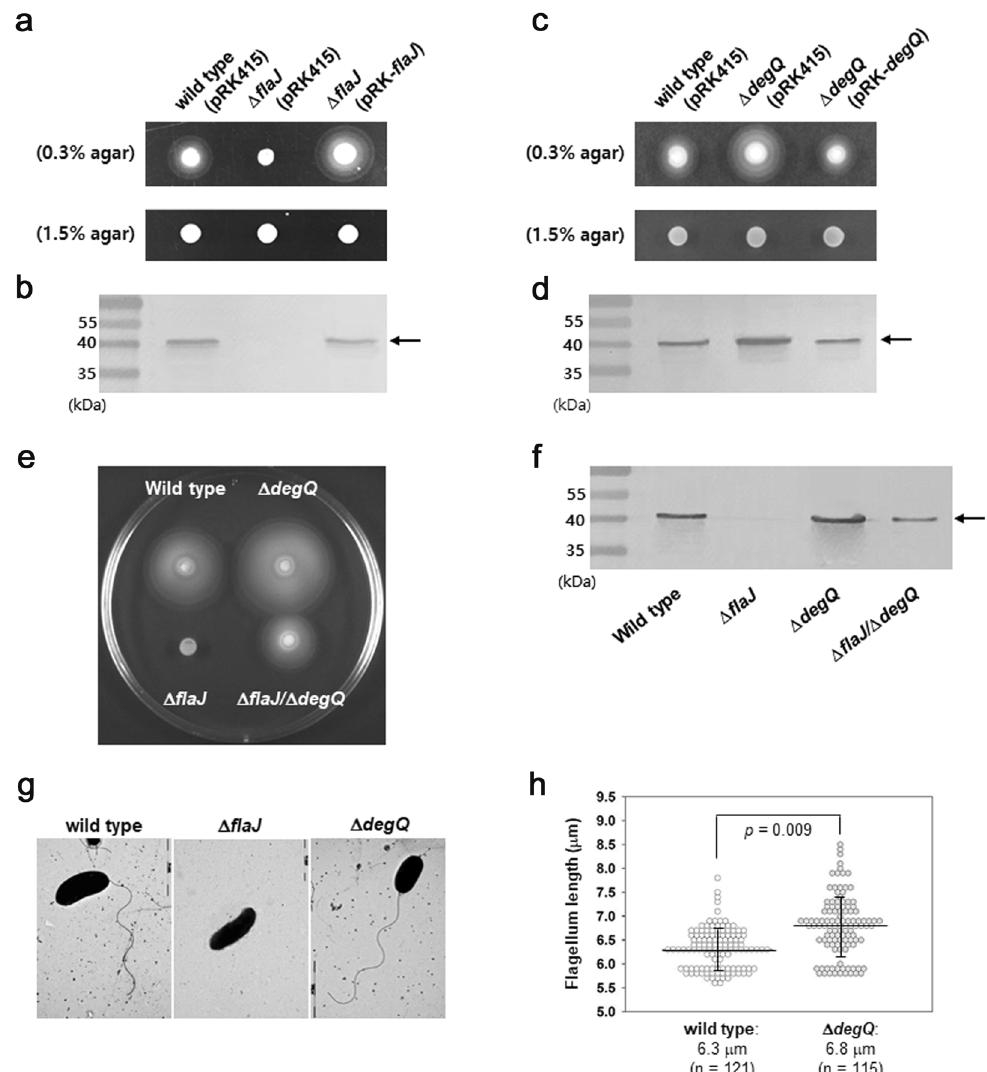
Fig. 1 Effects of the mutations in fl aJ or degQ genes on fl agellins, fl agella, and motility. a Effect of FlaJ on swimming motility on the soft- agar plate. Five microliters of the freshly grown cultures (at an OD of 1.0) of V. vulni fi cus strains of wild type and Δ fl aJ carrying a broad-host- range vector (pRK415) or a pRK415 harboring the intact fl aJ gene (pRK- fl aJ ) were spot-inoculated on a soft-agar plate made of LBS containing 0.3% agar, tetracycline (3 μ g/ml), and IPTG (1.0 mM), and incubated at 30 °C for 6 h. As a control for the inoculum size of each strain, the same volumes of the bacterial suspensions were spotted on the LBS-1.5% agar plate supplemented with tetracycline (3 μ g/ml) and IPTG (1.0 mM). b Effect of fl aJ deletion on the cellular levels of fl agellins. Cell lysates were prepared from the wild type carrying pRK415, Δ fl aJ carrying a pRK415, and Δ fl aJ carrying a pRK415- fl aJ . Ten micrograms of the crude cell extracts were subjected to SDS-PAGE and subsequently western blot analysis using the polyclonal antibodies reacting with the fl agellins produced by V. vulni fi cus , as previously described 12 . An arrow indicated the V. vulni fi cus fl agellin subunits. c Effect of DegQ on swimming motility on the soft-agar plate. V. vulni fi cus strains of wild type carrying pRK415 and Δ degQ carrying pRK415 or pRK- degQ were spot-inoculated on the LBS plates containing agar at a concentration of 0.3 or 1.5%, as described in ( a ). d Effect of degQ deletion on the cellular levels of fl agellins. Ten micrograms of cell extracts of wild type carrying pRK415, Δ degQ carrying pRK415, and Δ degQ carrying pRK415- degQ were subjected to SDS-PAGE and western blot analysis, as described in ( b ). e , f Effects of fl aJ / degQ -double mutations on motility and fl agellin levels. V. vulni fi cus strains of wild type, Δ fl aJ , Δ degQ , and Δ fl aJ / Δ degQ were spot-inoculated on a soft-agar plate and incubated at 30 °C for 8.5 h ( e ), as described in ( a ). Ten micrograms of cell extracts of the four strains were subjected to SDS-PAGE and western blot analysis ( f ), as described in ( b ). g , h Effects of FlaJ and DegQ on fl agellation. Individual cells of V. vulni fi cus strains of wild type, Δ fl aJ , and Δ degQ were observed under TEM to examine the polar fl agellum ( g ), as described in “ Methods ” . Lengths of fl agella on the TEM images were measured from 121 cells of wild type and 115 cells of Δ degQ ( h ). The distribution of fl agellar lengths was plotted with the medians (marked with a horizontal line) and their standard deviations (marked with a vertical line) of each strain and the P -value derived from comparison of two strains (Student ’ s t